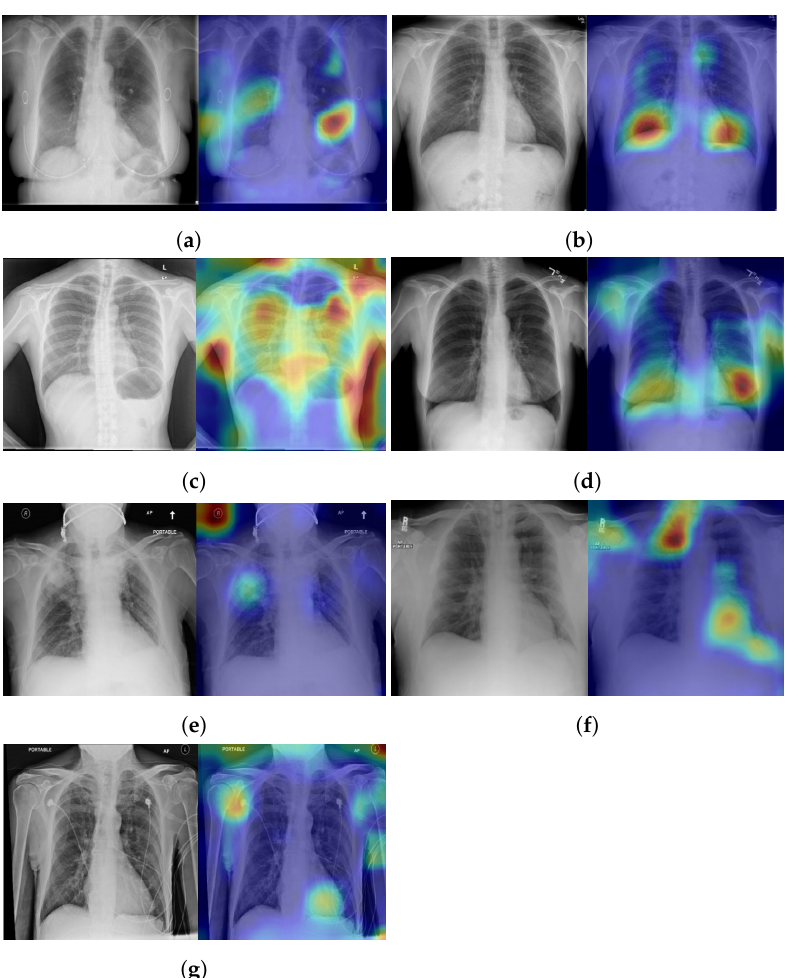
Figure 25. Examples of false positive and false negative cases detected by our deep learning models on CXR images: ( a ) and ( b ) CIDC; ( c ) SHENZHEN; ( d ), ( e ) and ( f ) RSNA; ( g )